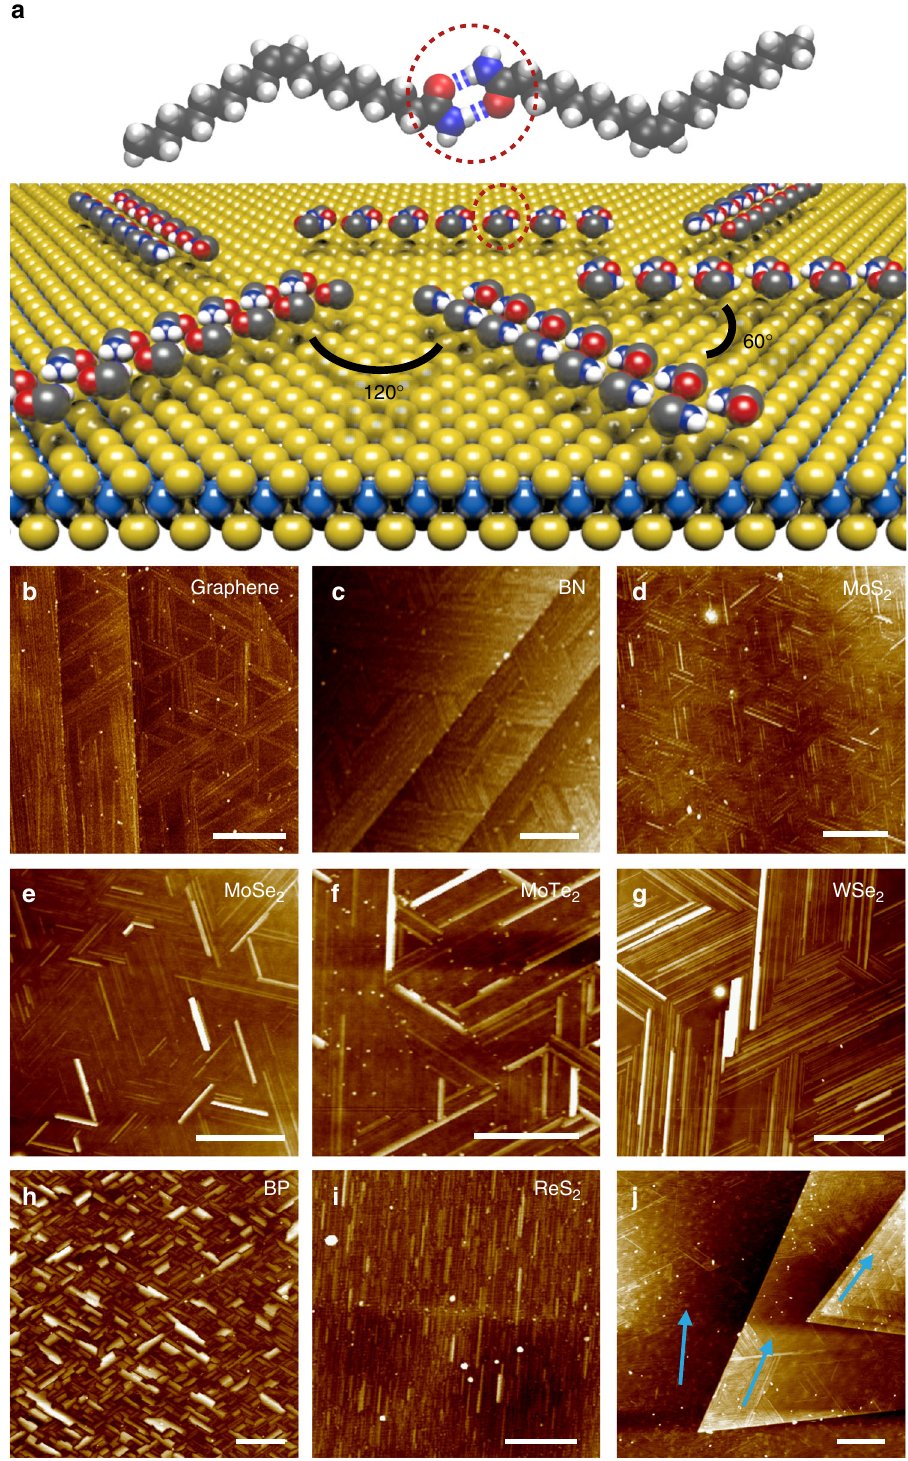
Fig. 1 Self-assembly of oleamide on various 2D atomic crystals. a Schematic representation of oleamide self-assembly on 2D atomic crystals along speci fi c orientations. For clarity, only the amide groups are displayed and the alkyl chains of oleamide are not shown except for the topmost oleamide dimer which shows the complete molecular structures. Hydrogen bonds are indicated with blue dashed lines. White , gray , blue and red balls represent H, C, N and O atoms, respectively. b – i AFM images of oleamide nanoribbons on graphene, h -BN, MoS 2 , MoSe 2 , MoTe 2 , WSe 2 , black phosphorus (BP) and ReS 2 , respectively. j Nanoribbons on CVD-grown multilayer MoS 2 . Blue arrows represent the orientations of nanoribbons on varied layers. All scale bars are 500 nm, except for that in c which is 200